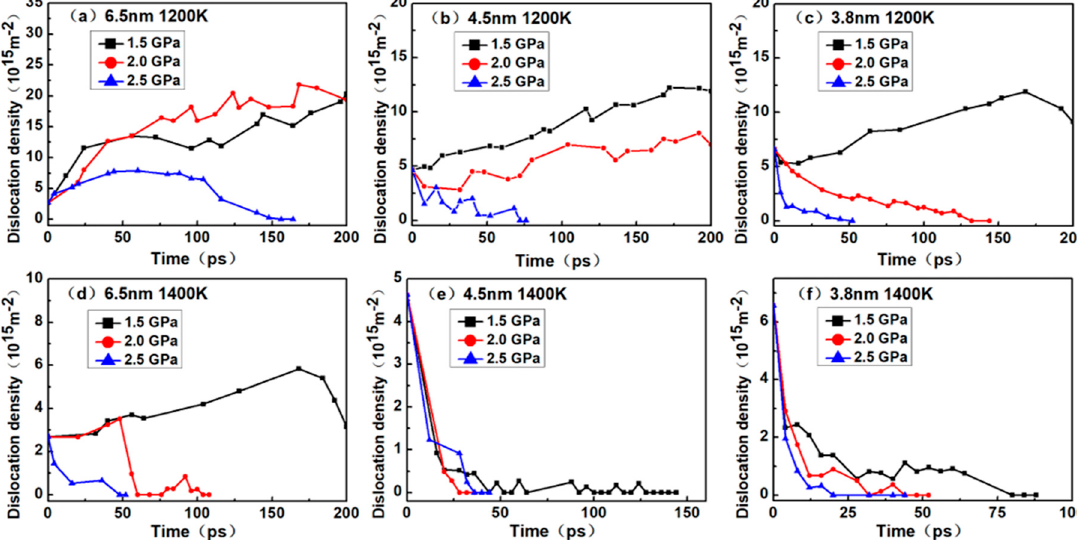
Figure 4. Plots of the dislocation density versus time for the nanocrystalline NiAl models with different grain sizes of ( a ) 6.5 nm at 1200 K; ( b ) 4.5 nm at 1200 K; ( c ) 3.8 nm at 1200 K; ( d ) 6.5 nm at 1400 K; ( e ) 4.5 nm at 1400 K; ( f ) 3.8 nm at 1400 K under the stress levels of 1.5, 2.0 and 2.5 GPa.